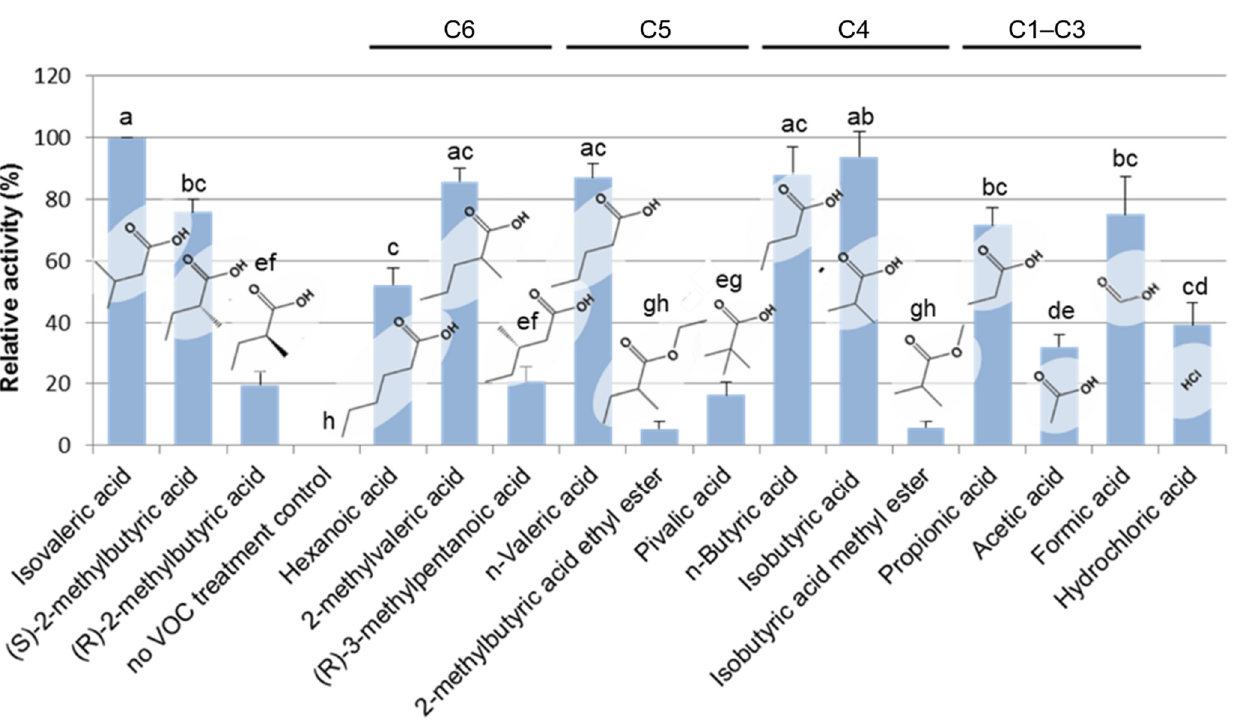
Figure 3. Structure–activity relationship of IVA and its analogs. Various structural analogs of IVA were subjected to the bioassay for detecting plant growth-inhibiting activity by monitoring the inhibition of seminal root elongation. The inhibitory activity of seminal root elongation exhibited by each chemical was evaluated after 5 days of incubation and presented as values relative to that of isovaleric acid. It is notable that ( R )-2-methylbutyric acid showed significantly lower activity of plant growth inhibition compared with ( S )-(+)-2-methylbutyric acid, which is one of the two major BVOCs among Bacillus BVOCs. C1–C6 represents the number of carbon atoms in the main chain length of each compound. Mean values (± SD) of the plant growth inhibition activity of each standard chemical that are represented as the relative activity to that of IVA. Different letters indicate significant differences according to Tukey’s means comparison test ( p ≤ 0.01). The error bars represent the SD. (n = 3).